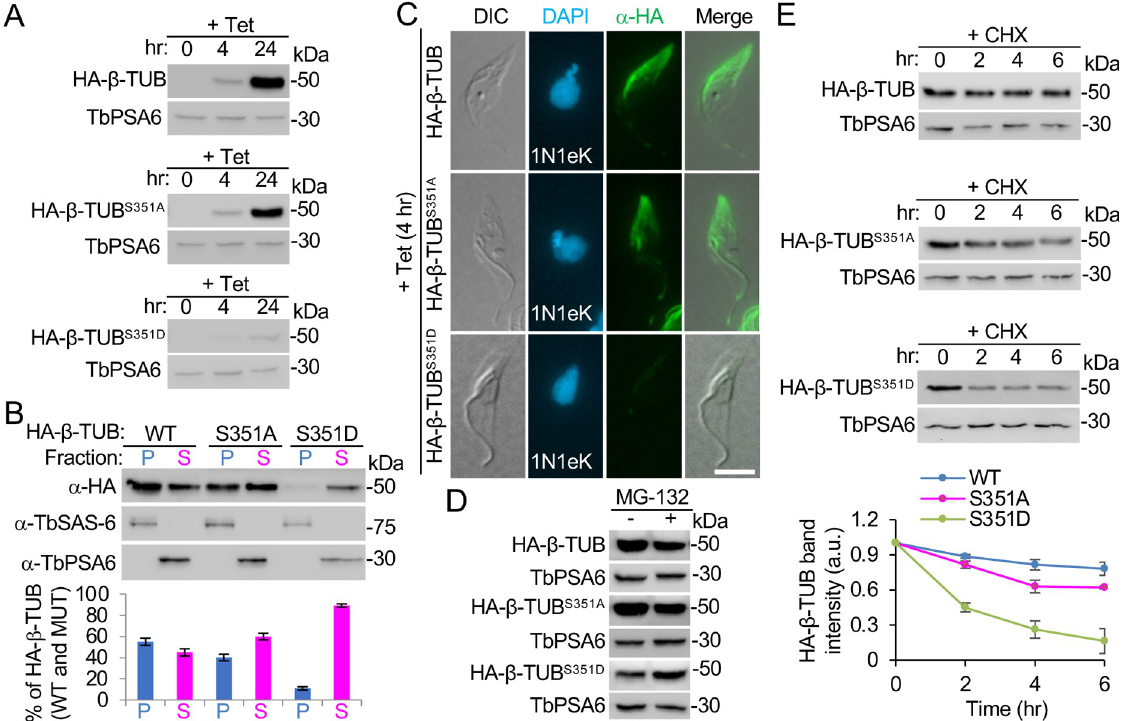
Fig 7. Effects of Ser-351 phosphorylation on the incorporation of β -tubulin into microtubules. ( A ). Ectopic expression of control tagged β -tubulin, the S351A mutant, and the S351D mutant in T . brucei . TbPSA6 served as a loading control. ( B ). Distribution of control tagged β - tubulin, the S351A mutant, and the S351D mutant in the cytosolic and cytoskeletal fractions of T . brucei cells. The histogram shows the relative amounts of control tagged β -tubulin and its mutants, and error bars indicate S.D. from three independent biological replicates. ( C ). Incorporation of control tagged β -tubulin, the S351A mutant, and the S351D mutant into the subpellicular microtubules examined by immunofluorescence microscopy with FITC-conjugated anti-HA antibody. Scale bar: 5 μ m. ( D ). Effect of MG-132 treatment on the stability of control tagged β -tubulin, the S351A mutant, and the S351D mutant. TbPSA6 served as a loading control. ( E ). Stability of control tagged β - tubulin, the S351A mutant, and the S351D mutant examined by cycloheximide pulse-chase experiment. The histograms show the band intensity of the β -tubulin mutants, which was normalized against the loading control (TbPSA6) and then expressed relative to the first time point (0 hr). Error bars indicate S.D. from three independent biological replicates.